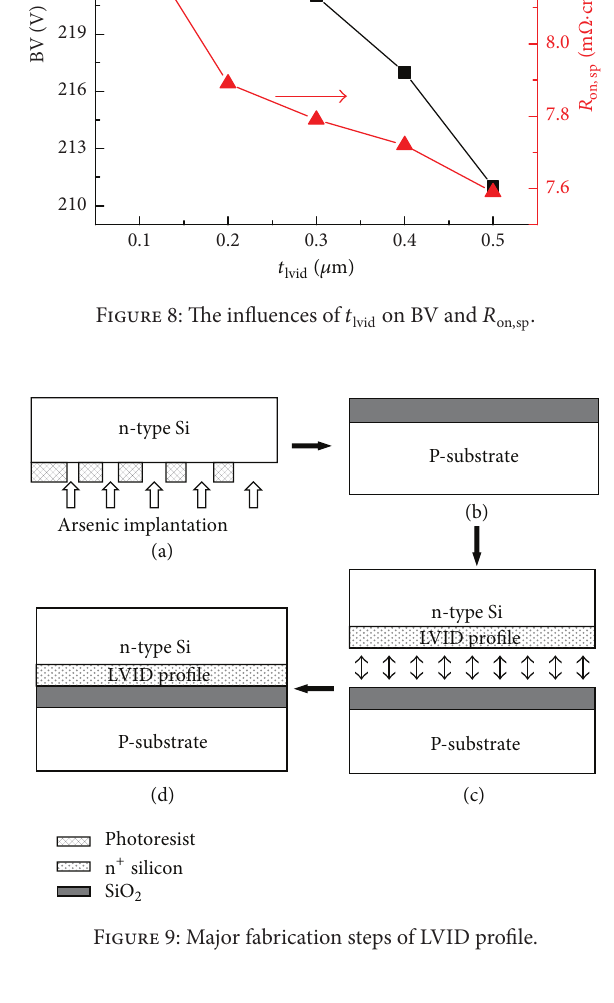
Figure 9: Major fabrication steps of LVID